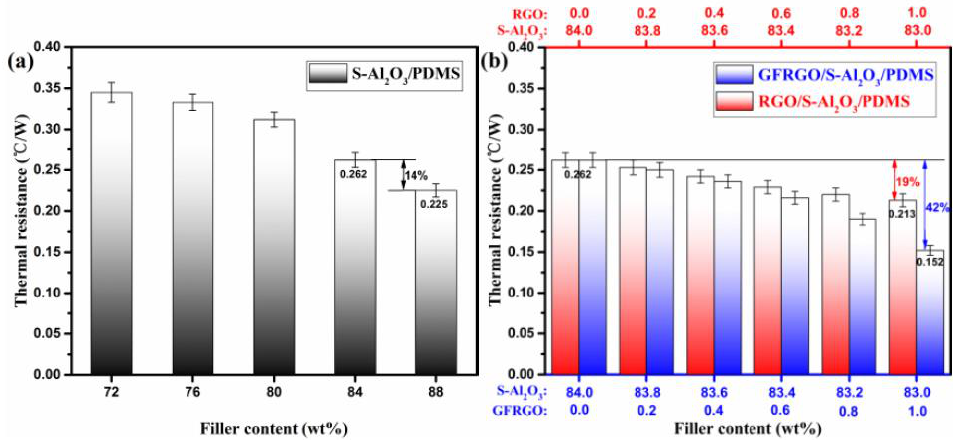
Figure 6. Thermal resistance of ( a ) S-Al 2 O 3 /PDMS composites and ( b ) GFRGO/S-Al 2 O 3 /PDMS and RGO/S-Al 2 O 3 /PDMS composites with different filler contents.